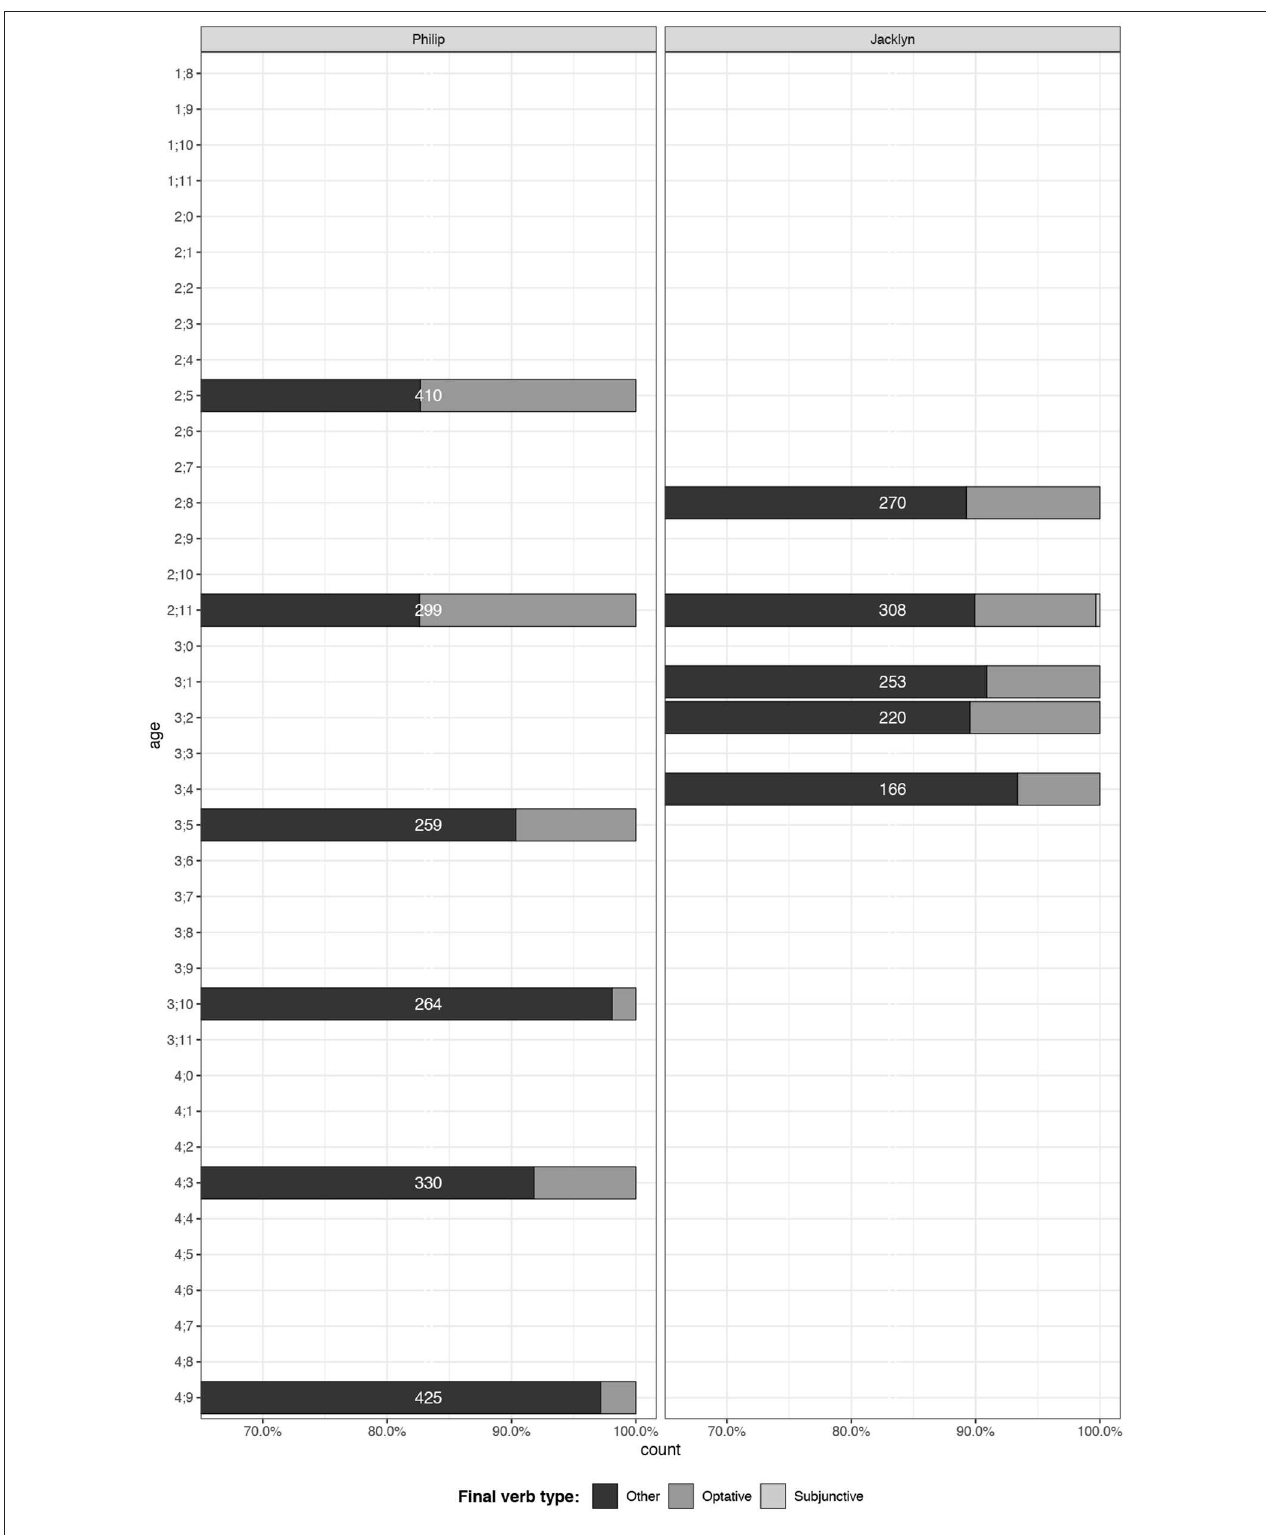
FIGURE 10 | Proportions of Optative and Subjunctive vs. other clause chain-final verbs in speech of adults to Philip and Jacklyn.